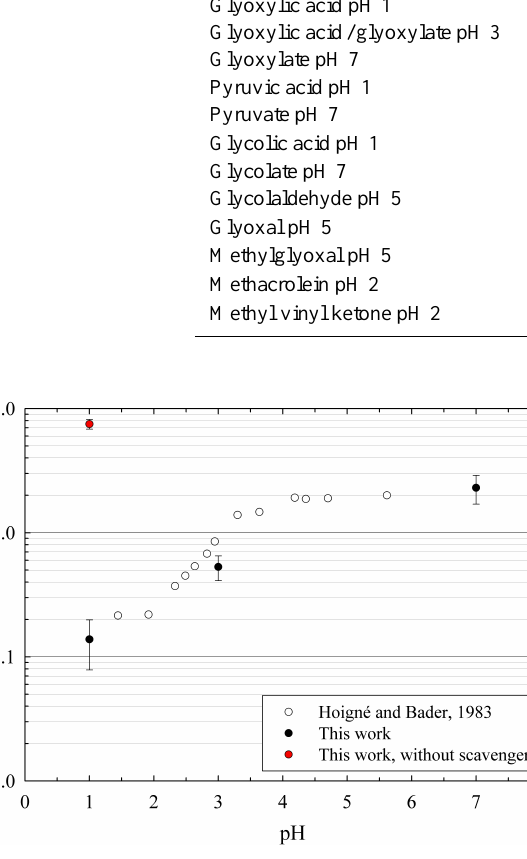
Fig. 2. Rate constants [M − 1 s − 1 ] plotted as a function of pH value for the reaction of glyoxylic acid/glyoxylate with ozone. Hoigné and Bader (1983b; white dots); this work (black dots); no scavenger used in this work (red